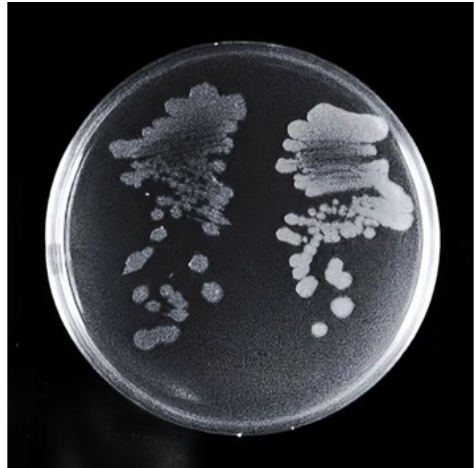
Figure 1. Comparison of colony morphology between S1 ( left ) and U3 ( right ). Strains were streaked on LB solid medium plate and incubated at 37 ◦ C for 36